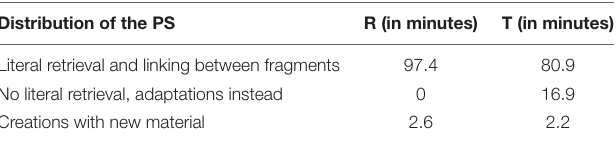
TABLE 2 | Dedication of time in percentages of the practice session of flamenco apprentices with Reproductive (R) approach, and with Transformative (T)